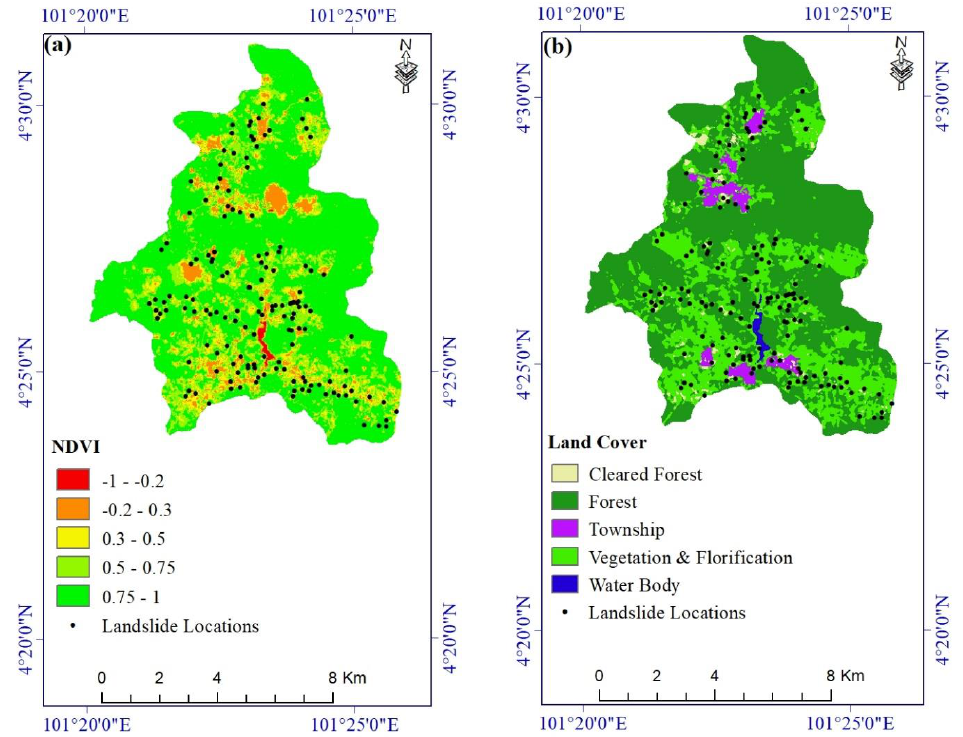
Figure 6. Landslide conditioning factors: ( a ) NDVI and ( b ) land cover.